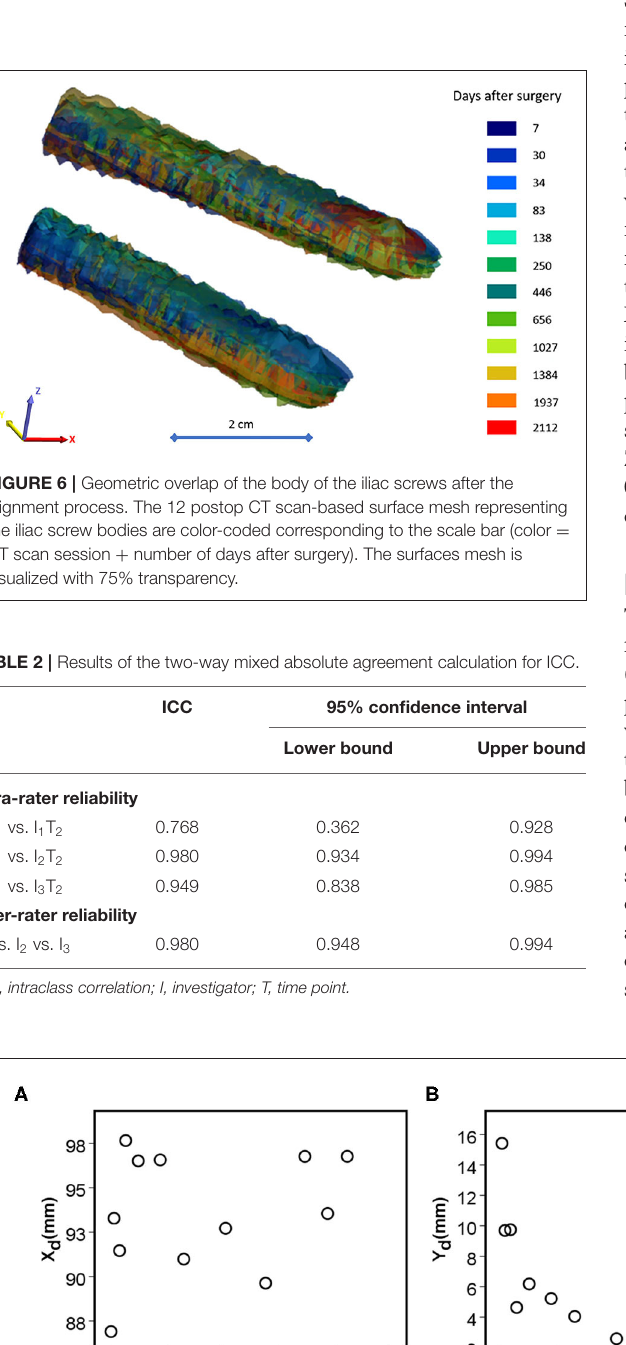
Frontiers in Surgery |